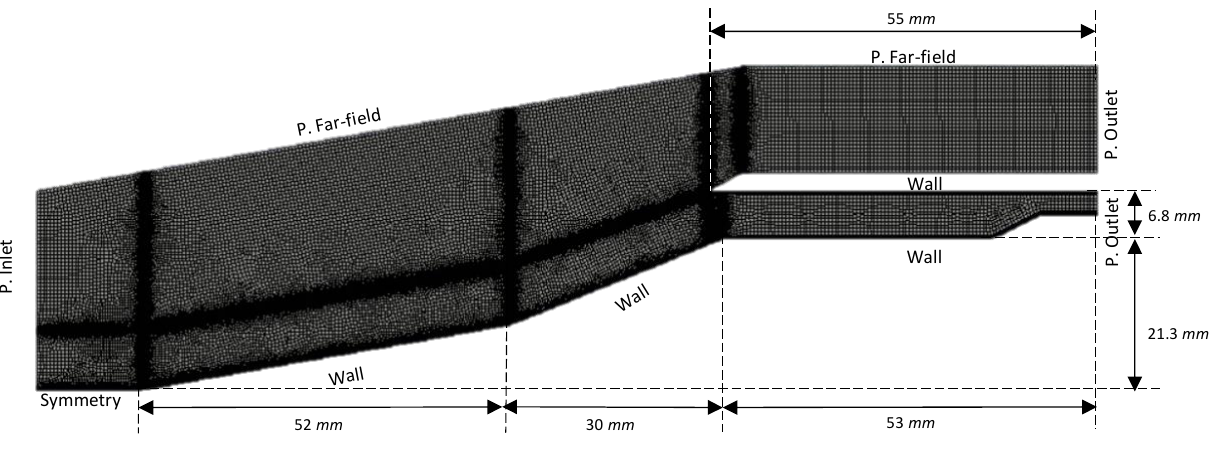
Figure 1: Mesh for the baseline case. Figure 1. Mesh for the baseline Figure 1. Mesh for the baseline case.